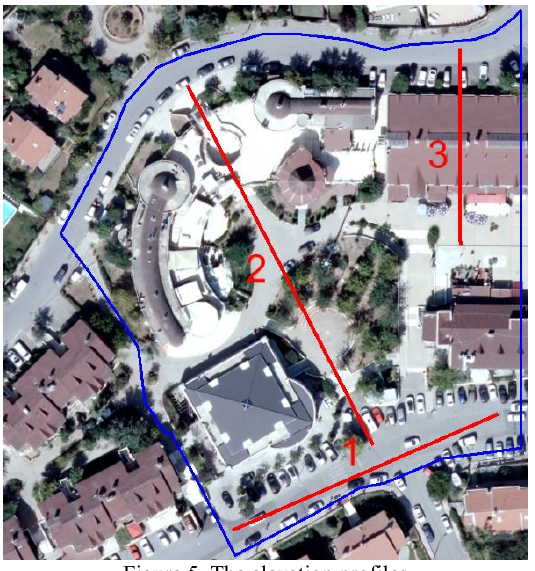
Figure 5. The elevation profiles